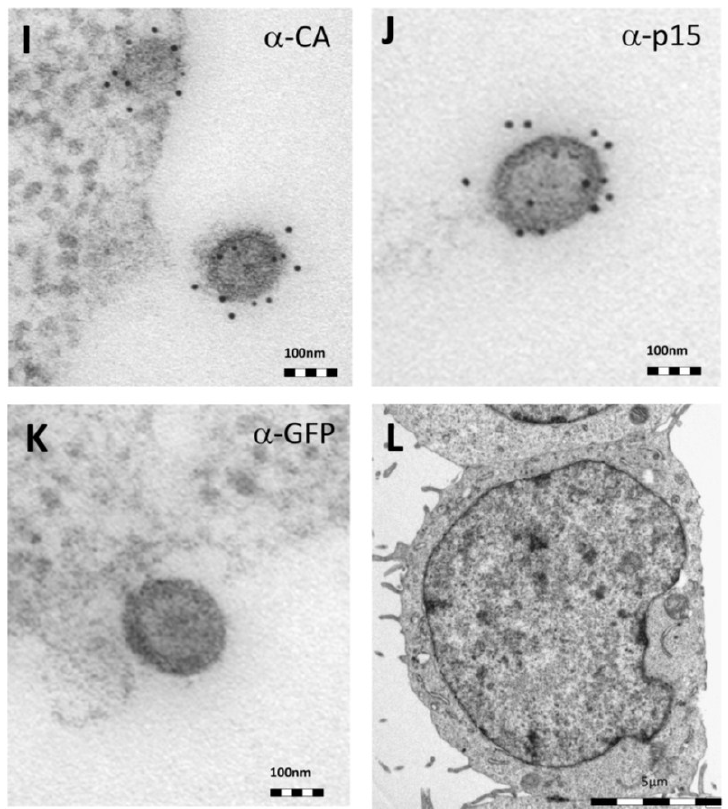
Figure 2. Thin-section electron micrographs of oriHERV-K113 and oricoHERV-K113 particle production after transfection with full-length molecular clones. ( A ) In HEK 293T cells, both immature oriHERV-K113 derived particles with ring-like structures of Gag proteins (marked by arrows) and mature forms with the condensed cores (marked by an arrowhead) are seen. ( B ) Env is incorporated strongly into the viral membrane (arrows). ( C ) Budding of oriHERV-K113 particles is of typical C-type morphology with the assembly of the Gag shells at the cellular membrane during budding (an arrow indicates a budding stage). ( D ) oriHERV-K113 particles produced in HeLa cells. ( E , F ) oricoHERV-K113 transfected HEK 293T cells produce large numbers of particles that line up with the cellular membrane and display an A-type morphology, predominantly with preassembled rings of Gag protein attached to the membranes. ( G ) oricoHERV-K113 occasionally forms budding chains with structures resembling C-type morphology (arrows). ( H ) Incorporation of Env into the viral membrane of oricoHERV-K113 appears to be very low. Shown is a released mature particle produced by HeLa cells ( I ) Immunostaining EM with a CA specific antiserum. ( J ) Immunostaining EM with a p15-specific antiserum and a GFP control antiserum ( K ). ( L ) No transfection